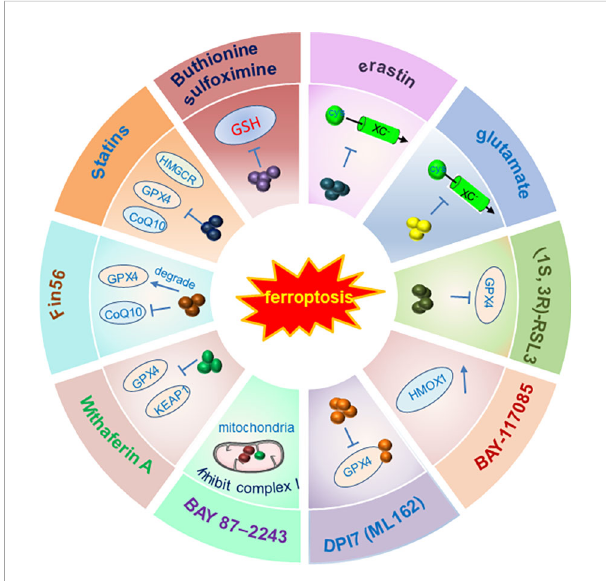
FIGURE 3 Schematic illustration of ferroptosis inducers targeting Xc - /GPX4 pathway. The developed ferroptosis inducers and their functional mechanisms were illustrated in the fi gure. And these ferroptosis inducers are designed mainly to target the Xc - /GPX4 pathway. Not all the currently reported small molecules were listed in the fi